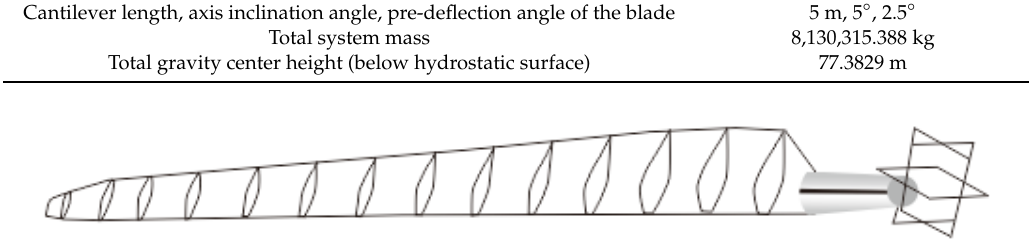
Figure 3. Blade layout. Figure 2. Blade structure of NREL 5 MW wind Figure 2. Blade structure of NREL 5 MW wind turbine. Table 1. Overall parameters of NREL 5 MW wind turbine system.